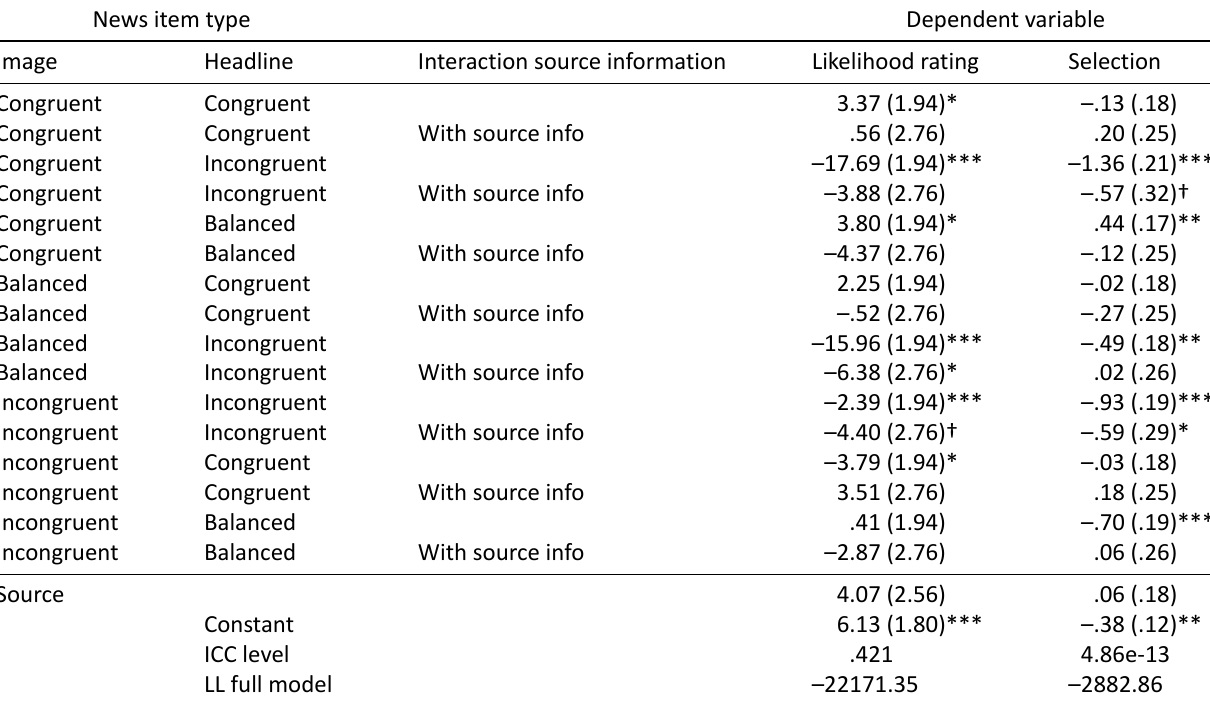
Table B2. Refugees context, multilevel models explaining peoples’ likelihood of viewing and selection of a news item, in- teracted with source